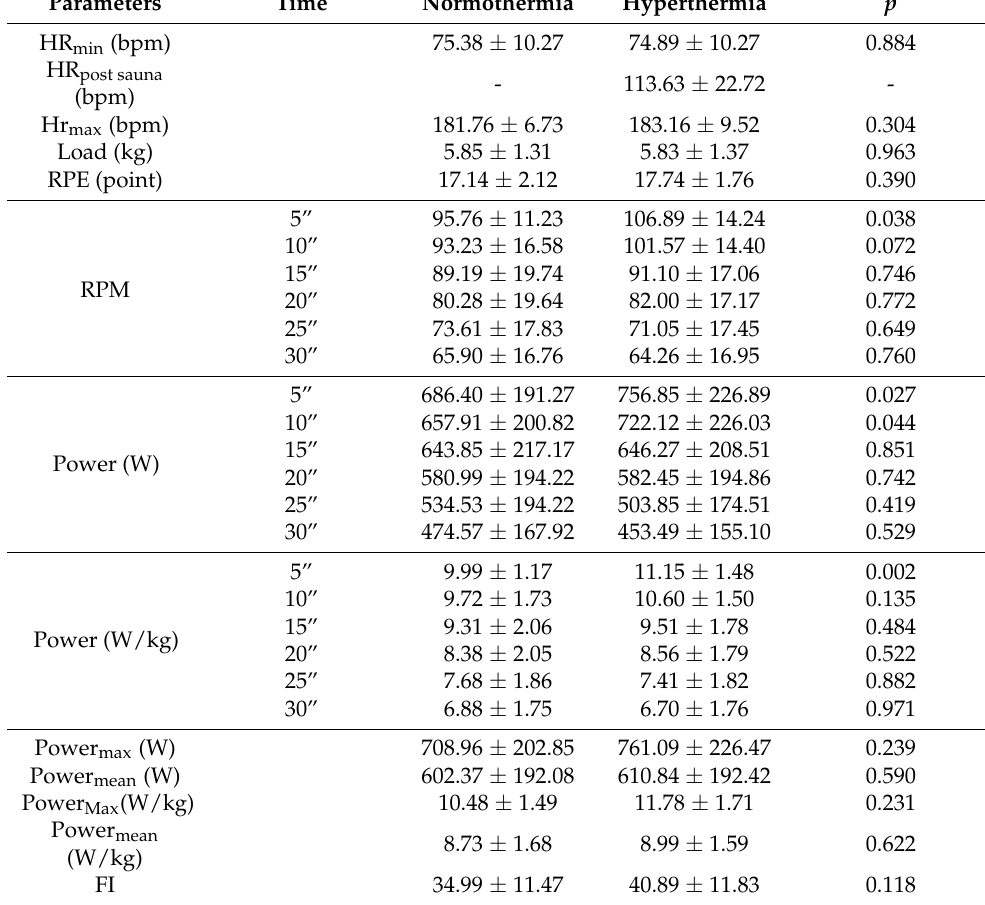
Table 5. Wingate test